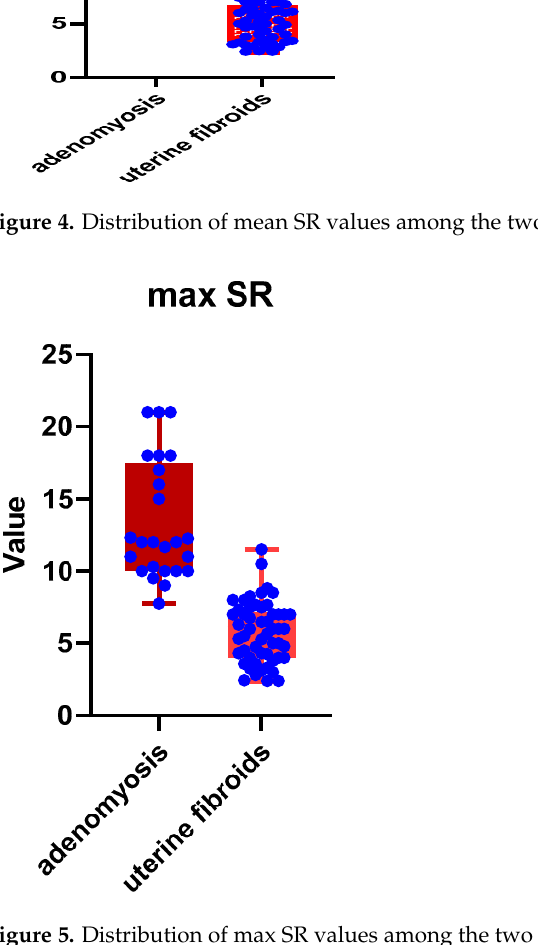
Table 5. Receiver operator characteristics (ROCs) analysis of mean and maximum SR values for distinguishing adenomyosis from uterine